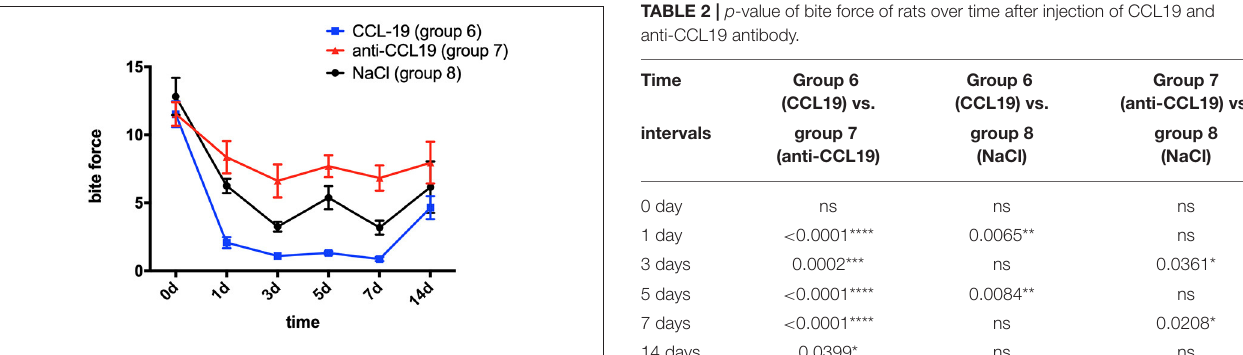
FIGURE 4 | Changes in pain expressed as the bite force of rats over time after injection of CCL19 and anti-CCL19 antibody. (The statistical analysis results related to the image are shown in Table 2 ).